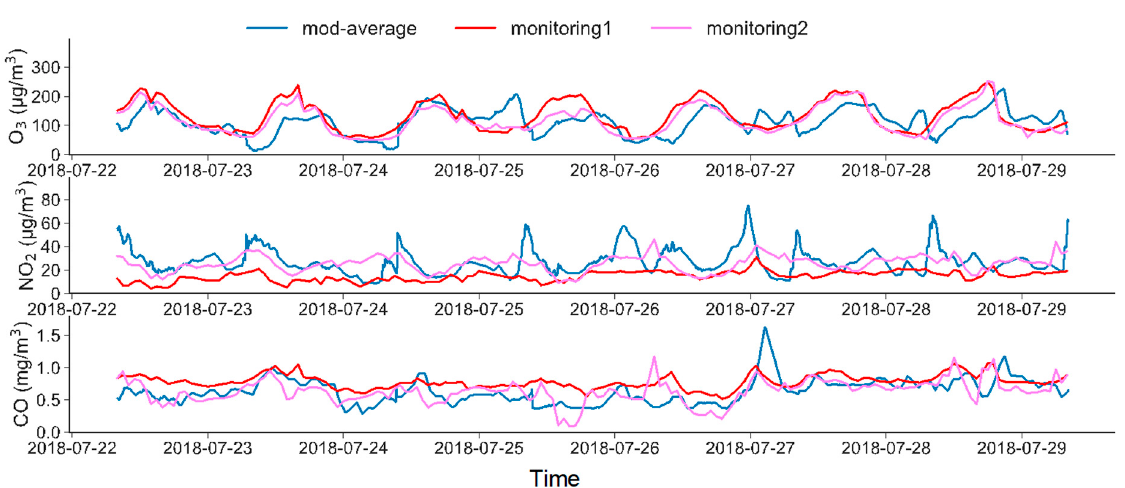
Figure 2. Time series of the observed and modelled O 3 , NO 2 and CO concentrations from 22 July to 29 July 2018. The blue line (mod-average) represents the spatially averaged model data, while the red line (monitoring 1) and the purple line (monitoring 2) represent the observation data retrieved from monitoring sites 1 and 2,